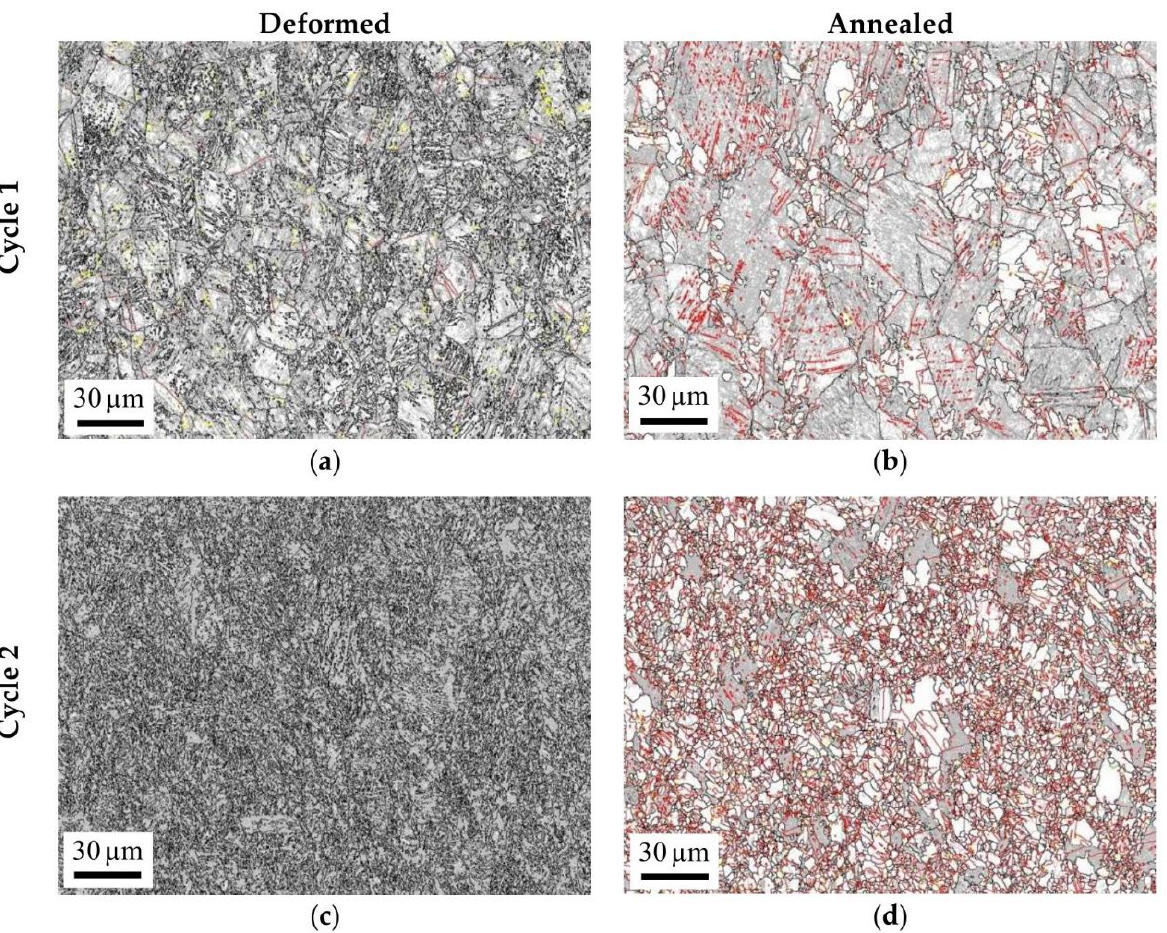
Figure 6. Grain boundaries construction maps for TMP samples processed using two cycles and strain of 0.20: ( a , b ) Cycle 1 and ( c , d ) Cycle 2.